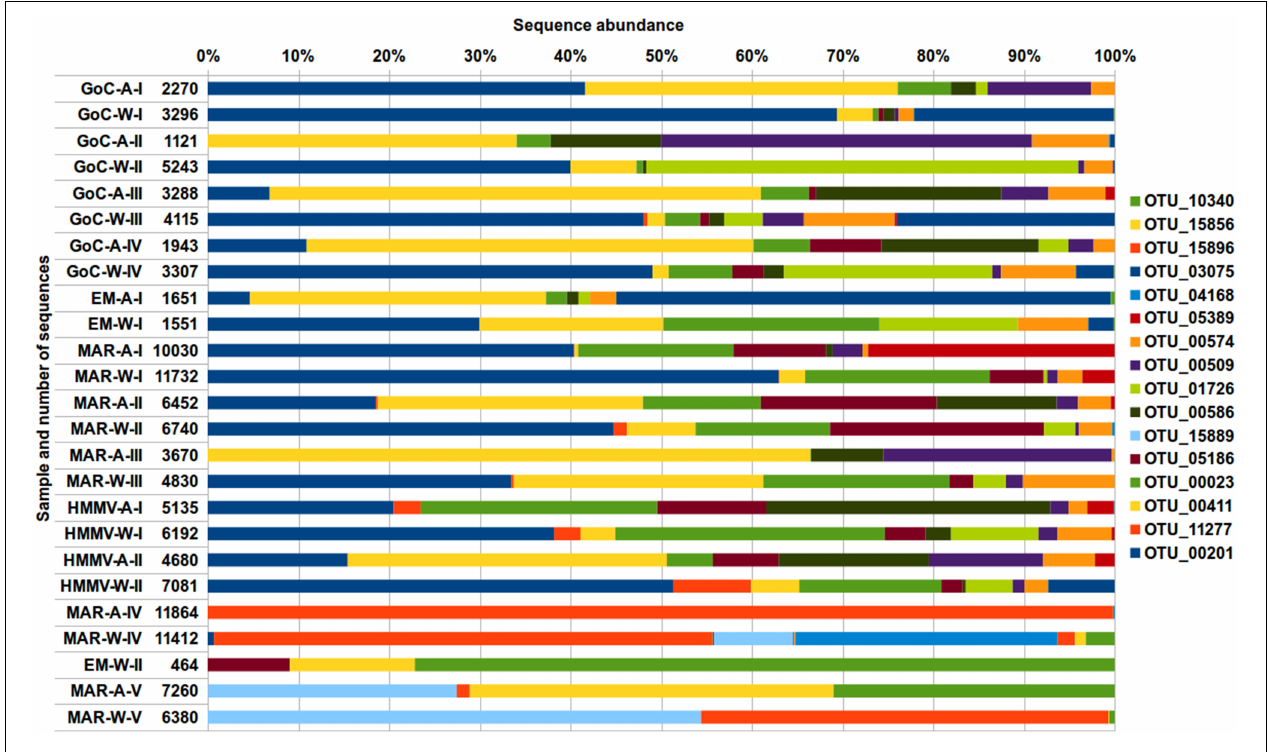
FIGURE 3 | Percentage of pyrosequencing reads representing the most abundant OTUs (more than 1% of the total number of sequences, i.e., > 3000reads)andassignedtodifferentbacterialphylotypes. Taxonomic